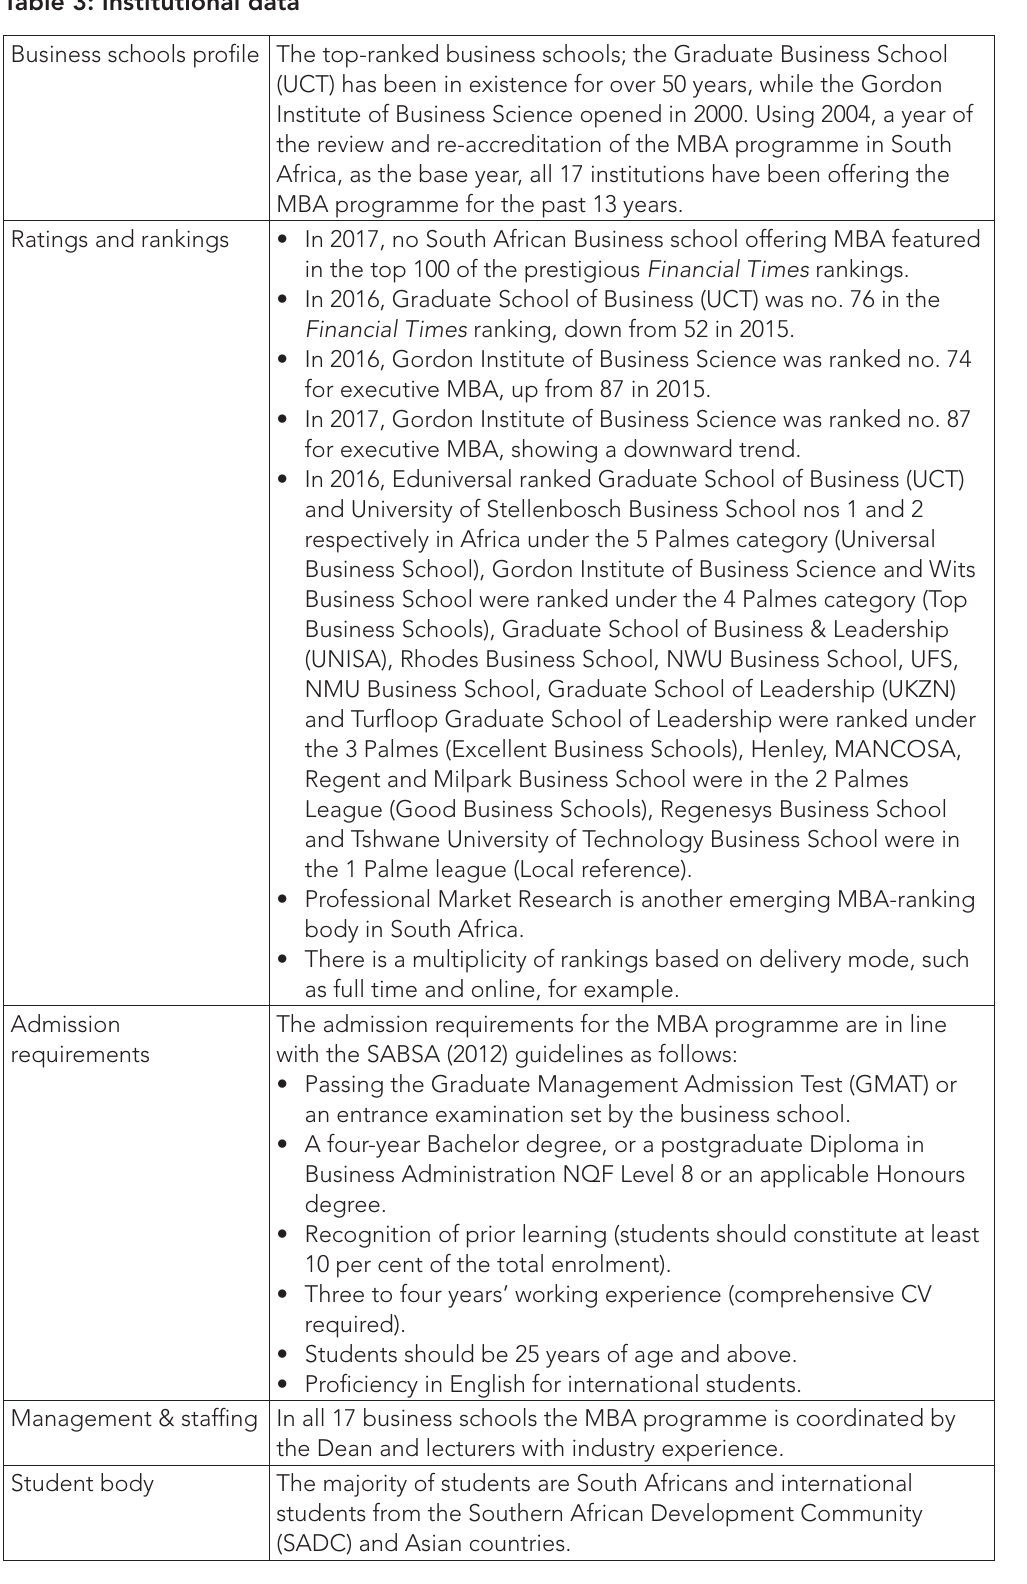
Table 3: Institutional data Business schools profile The top-ranked business schools; the Graduate Business